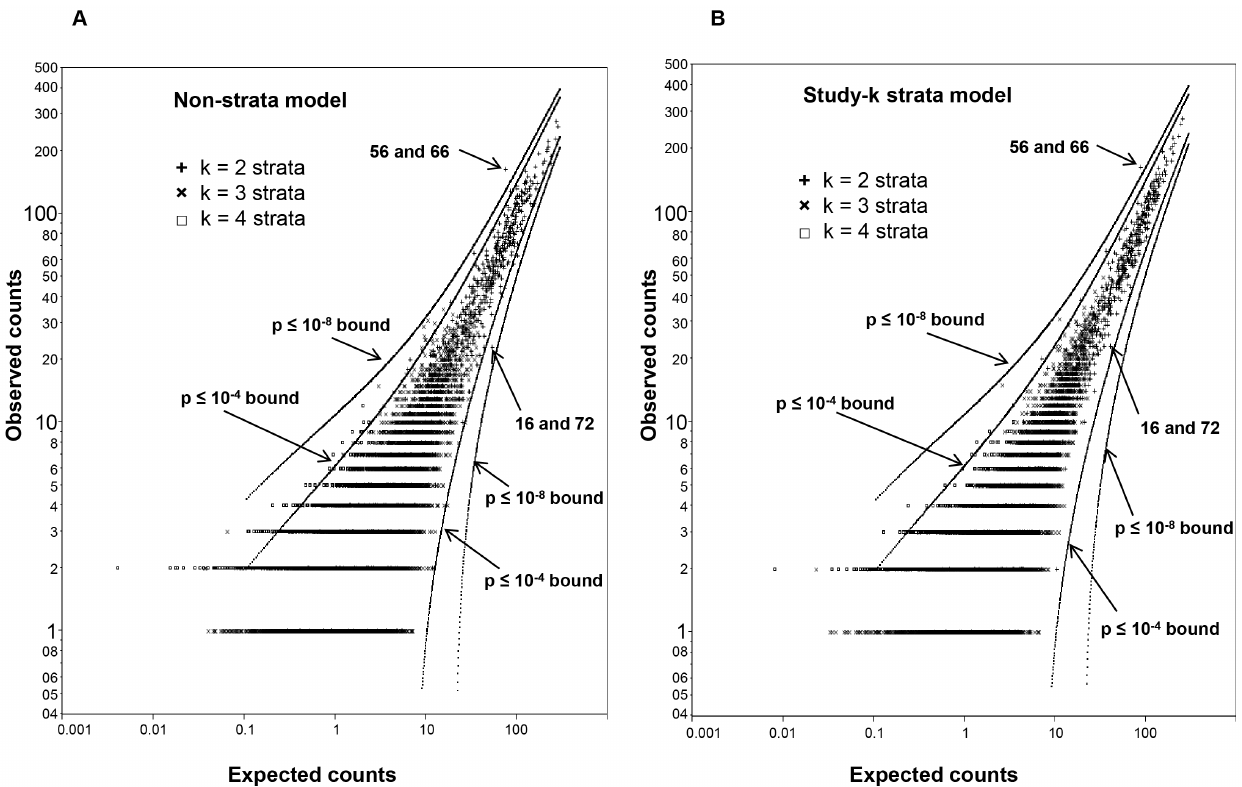
Figure 3. Significant combinations for k= two, three and four HPV types. The graphs depict the non-strata ( A ) and study-k ( B ) permutation models. Boundary lines (dots) show p-value significance at 10 2 4 and 10 2 8 . The mean expected counts on the x-axis represents the average number of observations from 1,000 randomized matrices; the y-axis shows the actual observed counts for the type combinations. Single observations of 4 HPV type combinations are